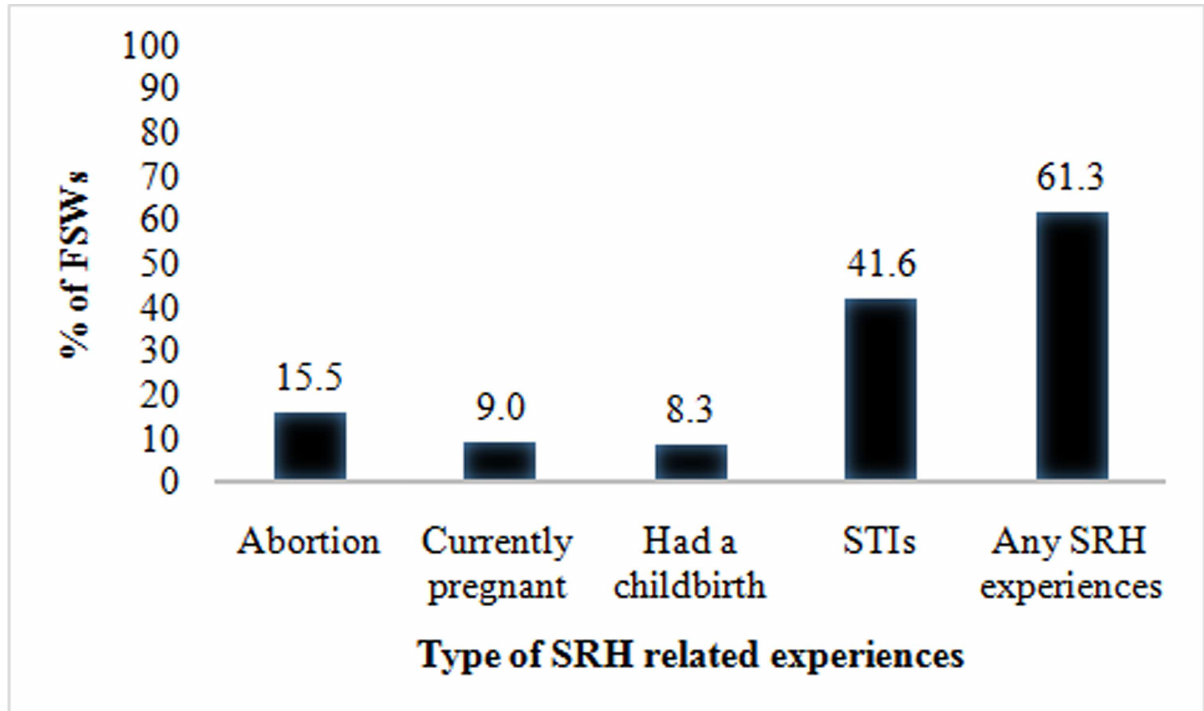
Fig 1. Proportion of FSWs who reported SRH experience in last one year by type of experience (n = 731).